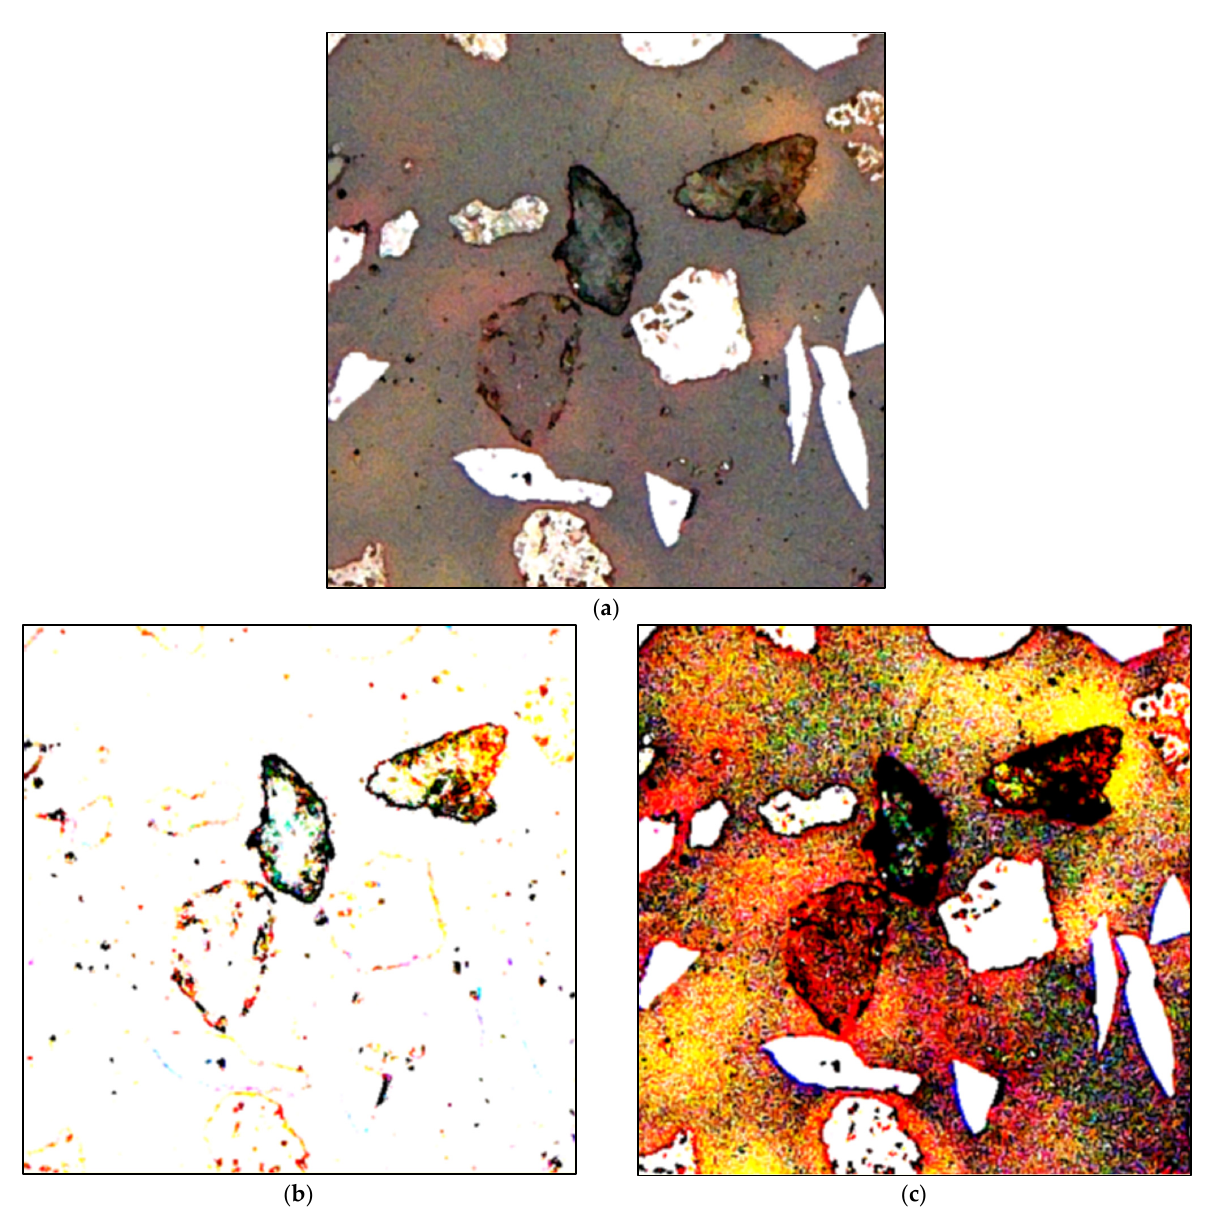
Figure 5. Generating “enhanced” view of the image from Figure 2, early steps: ( a ) selected range too wide (low threshold = 7000, high threshold = 15,000); ( b ) selected range below the optimal range (low threshold = 8000, high threshold = 9000); and ( c ) selected range above the optimal range (low threshold = 10,000, high threshold = 11,000).